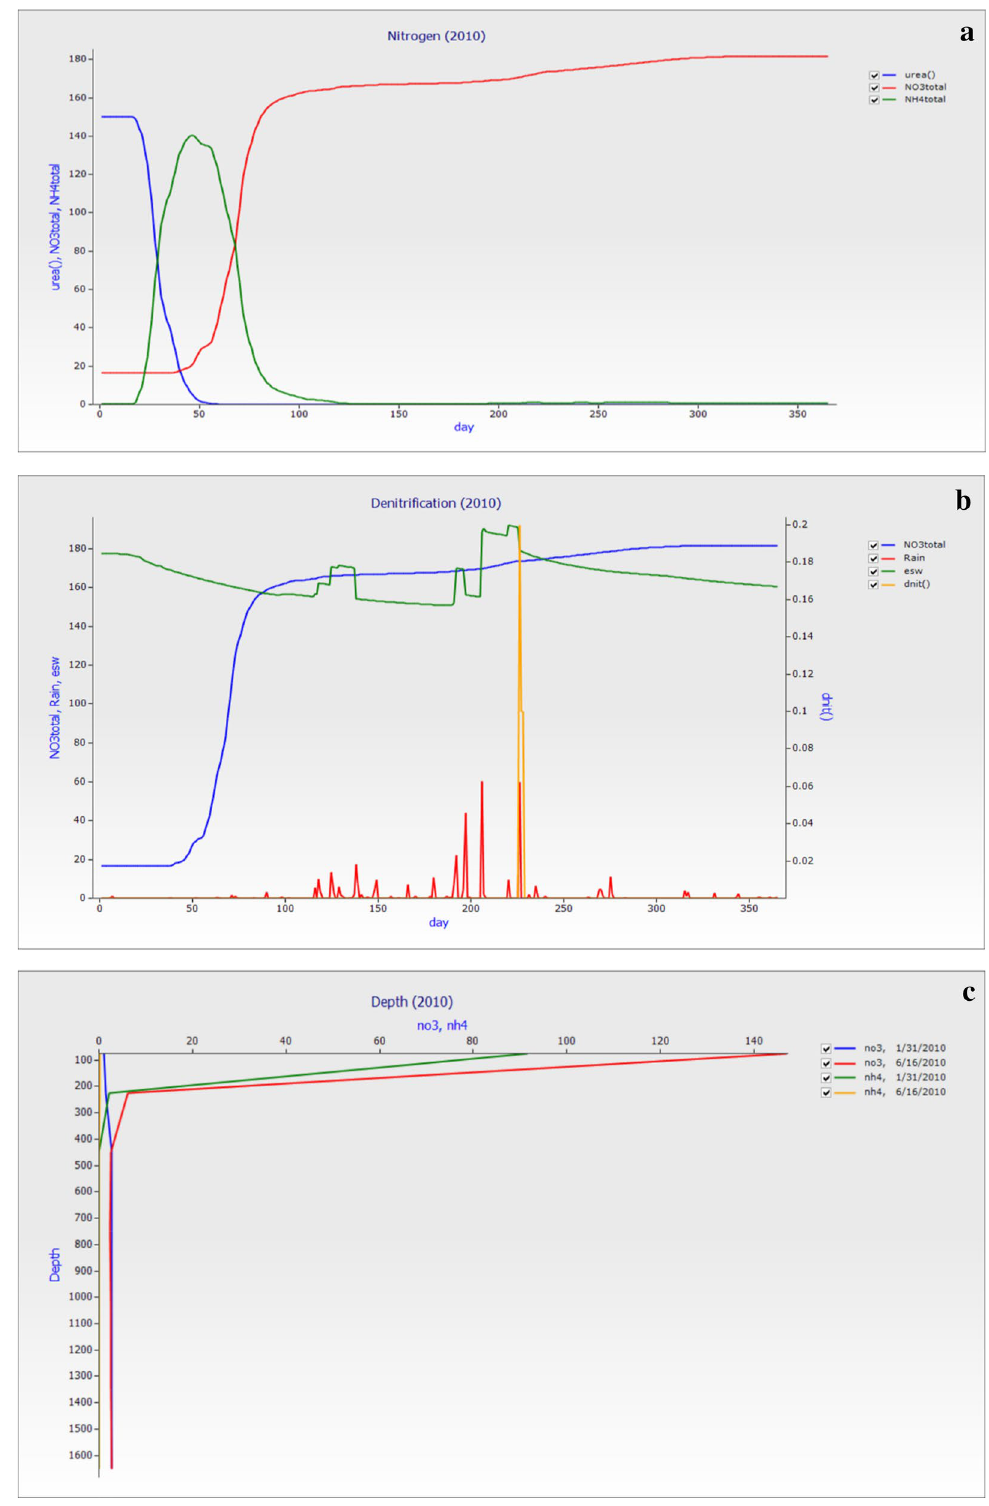
Figure 9. The graph was made on observed data for the year 2010 ( a ). The soil nitrogen Total (NO 3− –N, and NH 4+ –N) and urea versus day. ( b ) The days of the years versus denitrification (dnit), rainfall, esw, and total NO 3− –N while ( c ) depth of the profile versus NO 3− –N and NH 4+ –N with different year